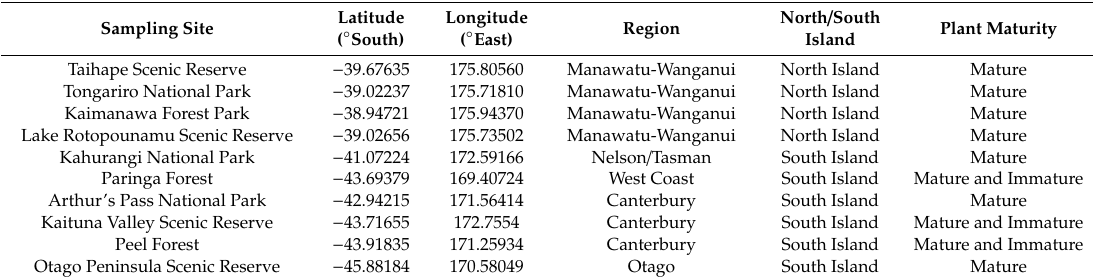
Table 5. Pseudowintera colorata sampling sites across New